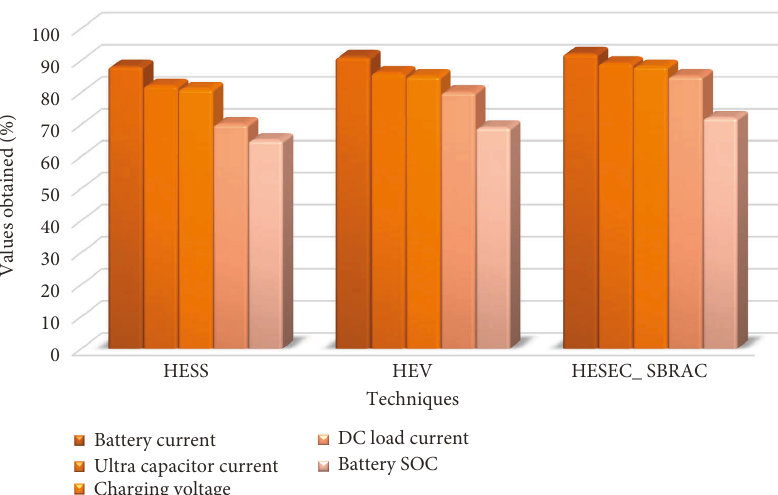
Figure 9: Comparative analysis of the constant acceleration case.